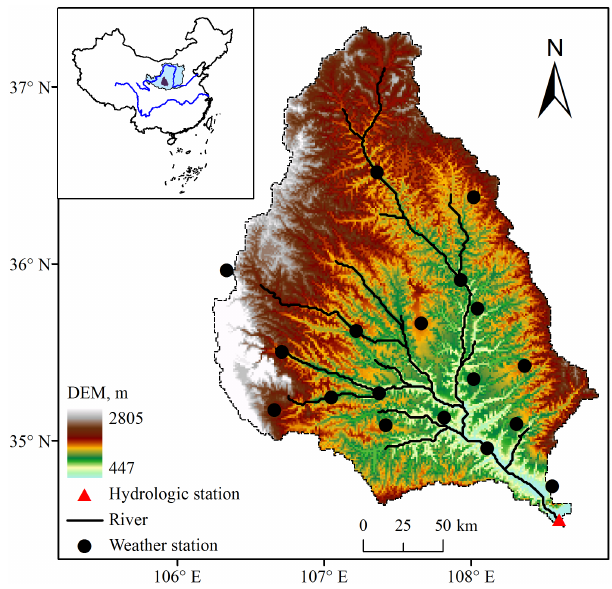
Figure 1. Location of the Jing River catchment with superimposed digital elevation model